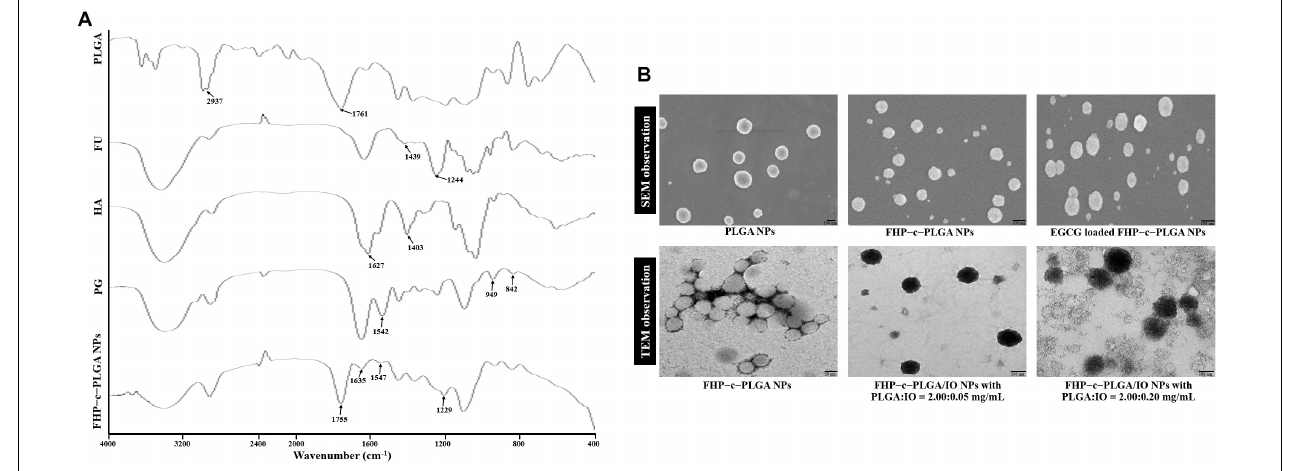
FIGURE 2 | (A) Fourier transform infrared analyses of PLGA, FU, HA, PG, and FHP–c–PLGA NPs. (B) Scanning electron microscopy (SEM) or transmission electron microscopy (TEM) micrographs of the different NP preparations. TABLE 2 | Effect of different epigallocatechin gallate (EGCG) concentration on particle sizes, polydispersity indices, zeta potential values, and drug-loading efficiency of EGCG loaded FHP-c-PLGA NPs ( n = 5). EGCG (mg/mL) Mean Particle Size (nm) Polydispersity indices Zeta Potential Value (mV) Loading efficiency (%) Loading content (%) FU/HA/PG concentration at 1.2:1.2:1.2